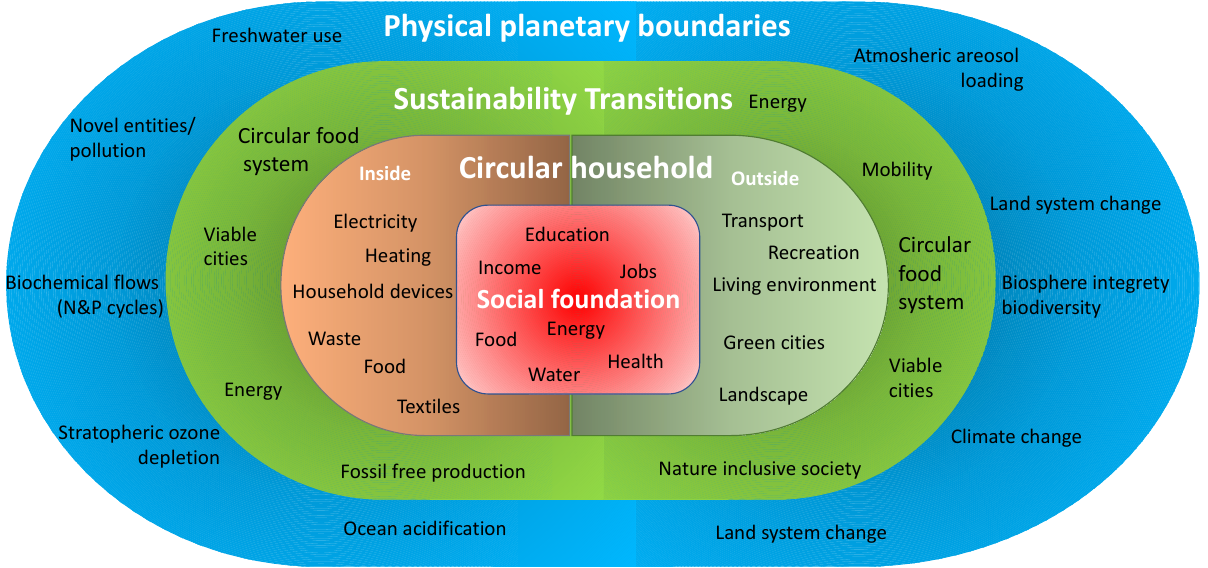
Figure 4. Graphical representation of the connection between the planetary boundaries (blue outer ring) and the social foundation (inner red square). The contribution of the circular household and the sustainability transitions related to climate change and biodiversity loss (see Figure 3) that are needed to create the safe operating space are depicted by the two inner rings.